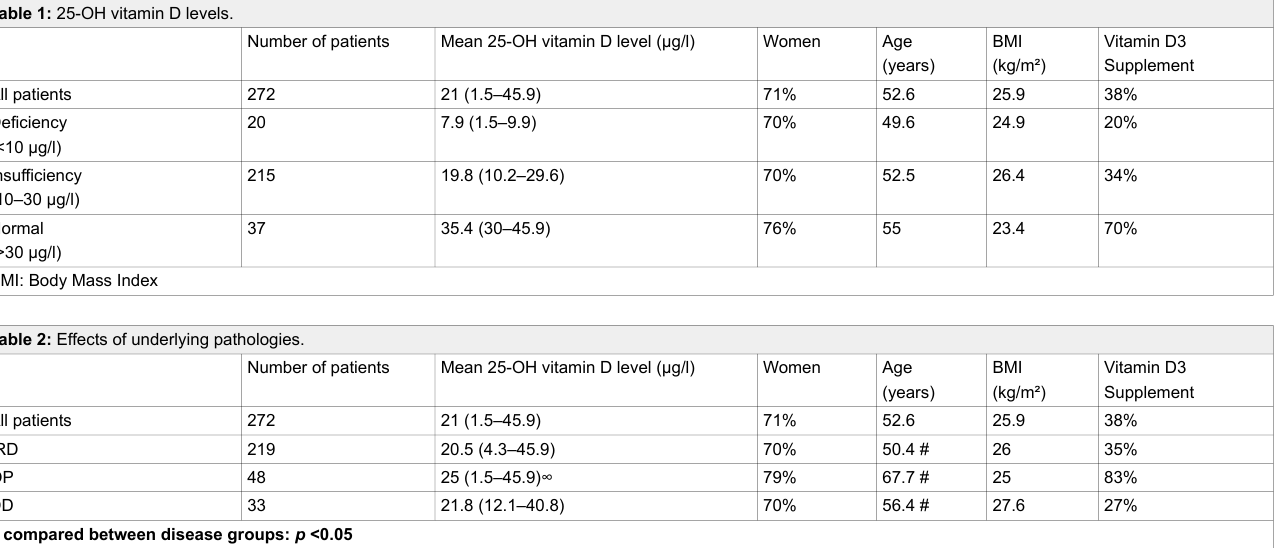
Table 1: 25-OH vitamin D levels.